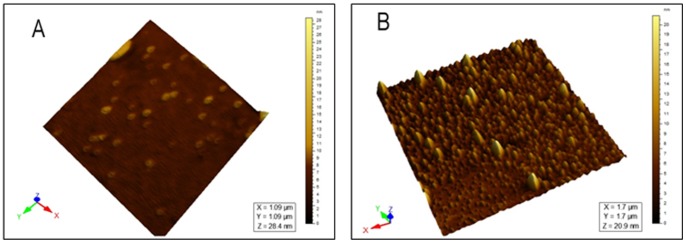
AFM study of AGnps.(A), 2D surface topography; (B), 3D particle distribution. The images revealed that prepared nanoparticles had regular spherical shapes with smooth surfaces in the zone of observation and equipment resolution. No apparent aggregation of nanoparticles was detected.